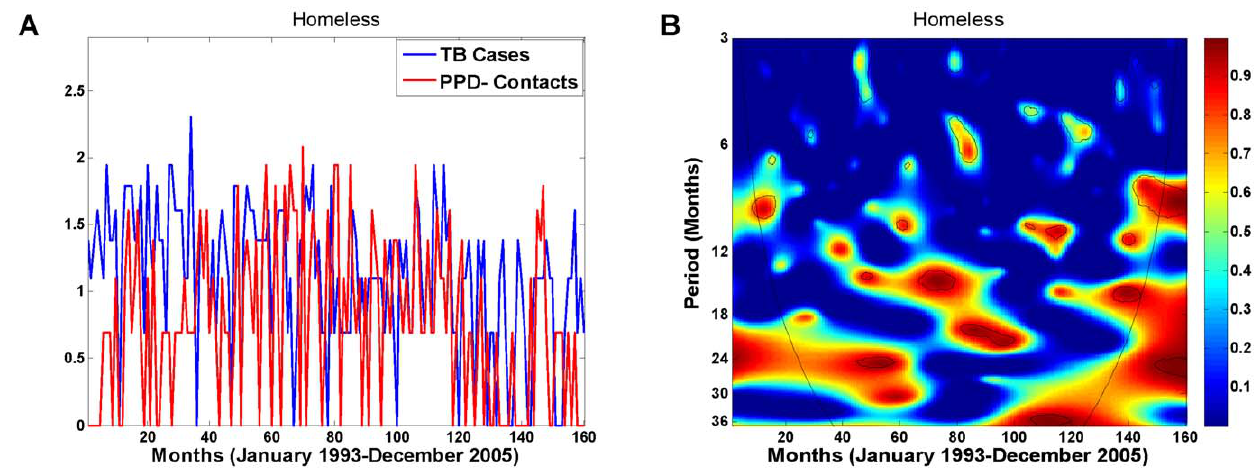
Figure 7. Wavelet time series analysis of the homeless TB cases and their PPD 2 contacts, January 1993–December 2005. (A) Log- transformed time series of the TB cases and their PPD 2 contacts. (B) Wavelet coherence between the homeless TB cases and their PPD 2 contacts. There is no evidence of a consistent periodic component and coherence between the two time series at any time scale (compare with Figure 4B).